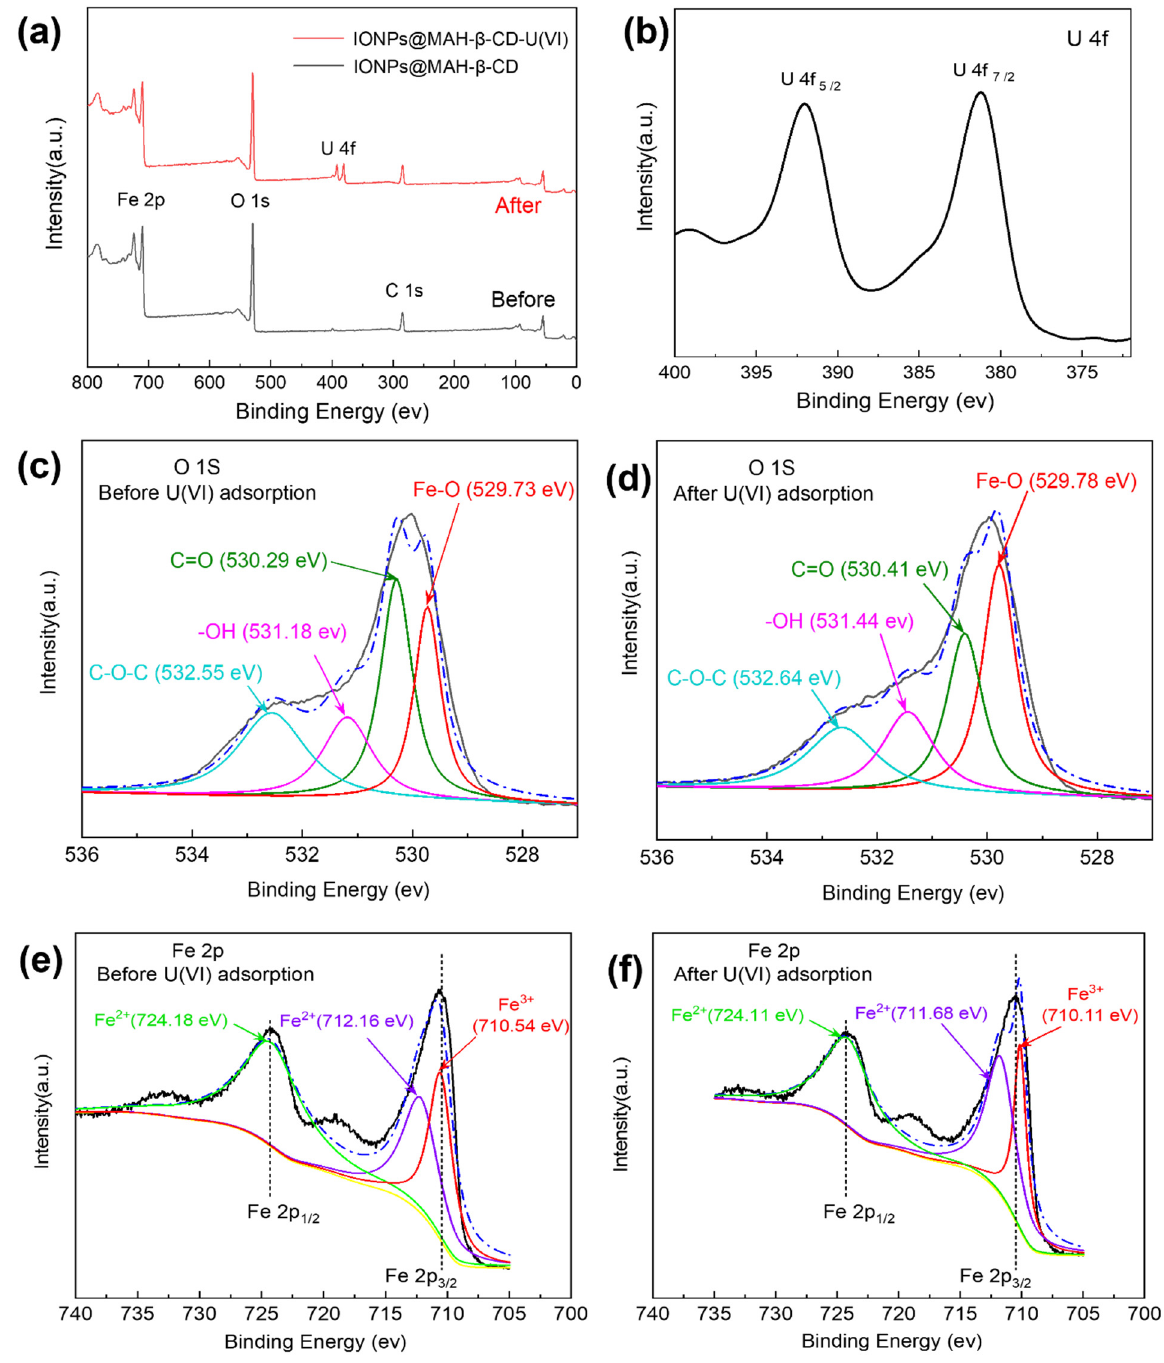
Figure 7. XPS spectra of IONPs@MAH- β -CD before and after U(VI) adsorption, full spectrum ( a ), U 4f ( b ), deconvolution of O1s before ( c ) and after adsorption ( d ), and deconvolution of Fe 2p before ( e ) and after adsorption ( f ).